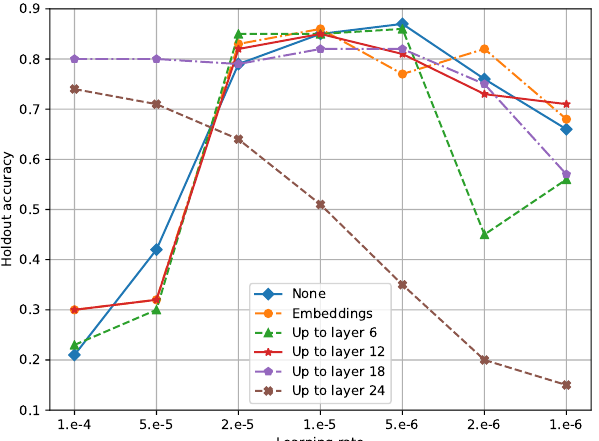
Figure 4. Holdout accuracies for different learning rates and subsets of weights to freeze during fine-tuning. Up to layer l in the legend indicates the setting that fixes the weights of the first l self-attention layers as well as the embeddings. Note that, since the experimented BERT contains 24 self-attention layers in total, the bottommost setting updates the regression layer